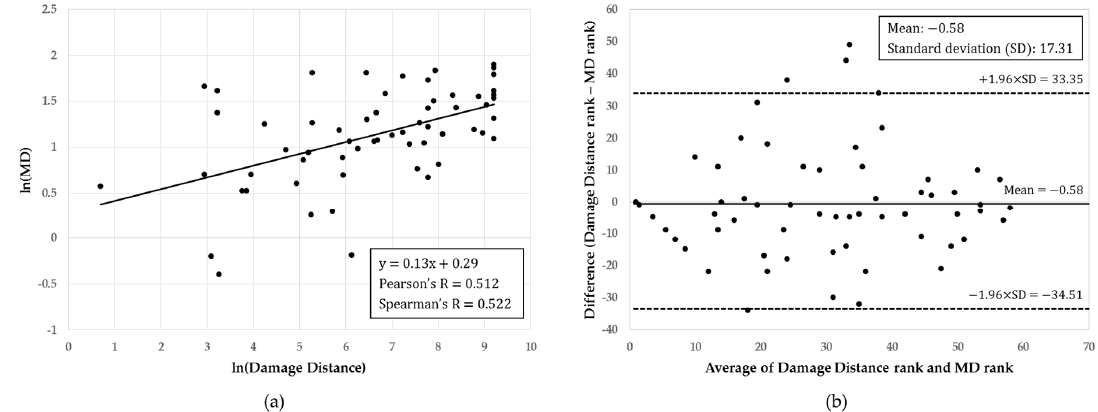
Figure 3. Comparison of matched ratio between MD and Damage Distance for 60 chemicals that require an accident plan: ( a ) Comparison between MD and Damage Distance and ( b ) Bland–Altman plot of MD and Damage Distance.